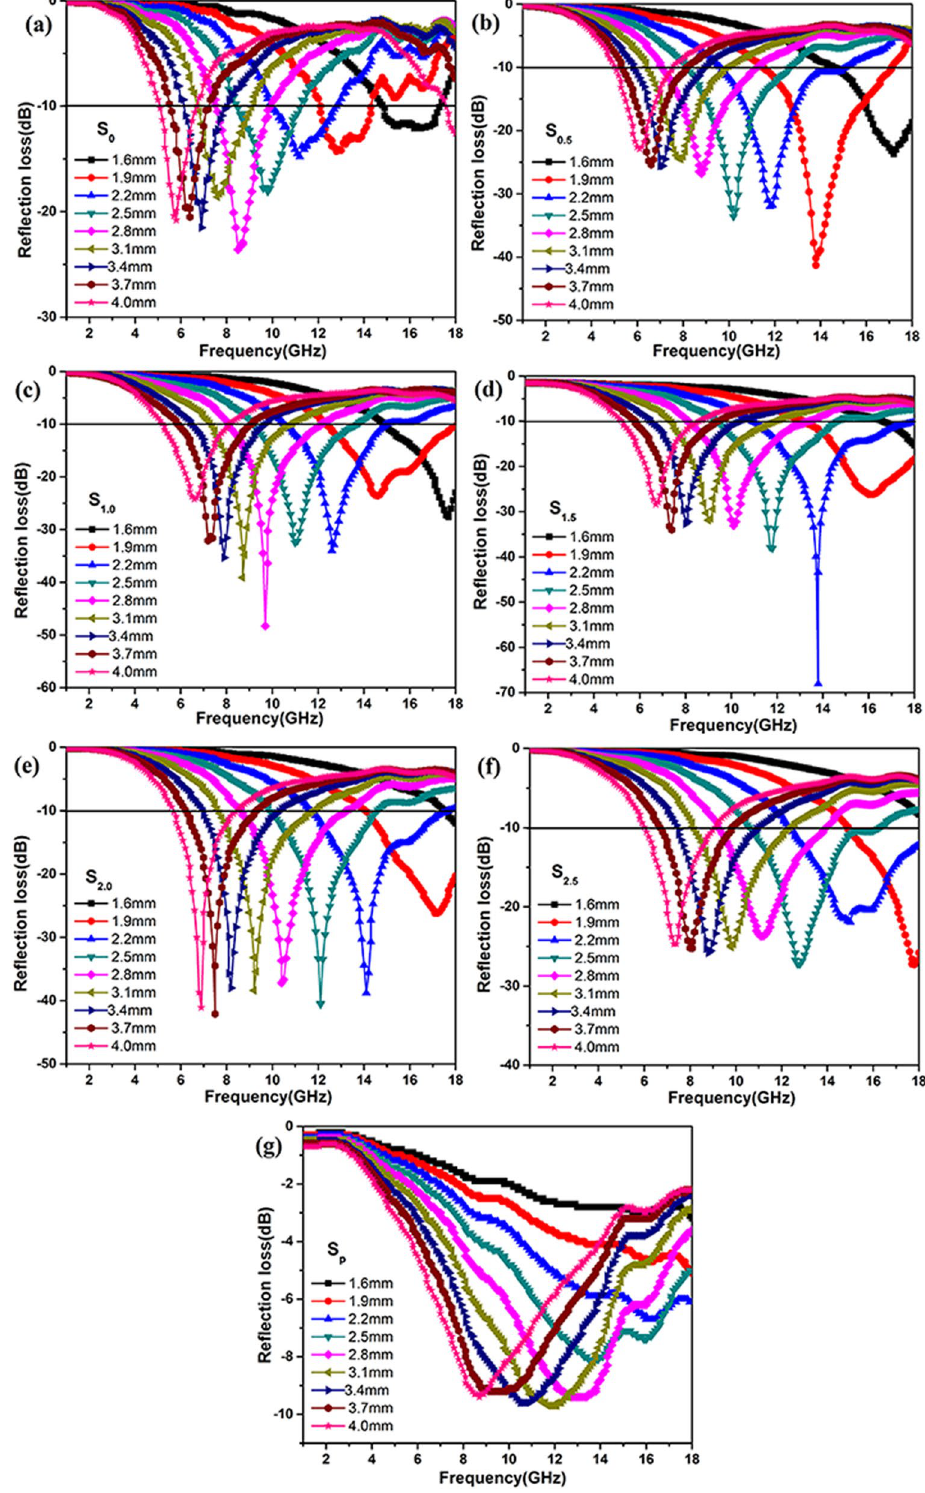
Figure 5. Calculated reflection loss of ( a ) S 0 , ( b ) S 0.5 , ( c ) S 1.0 , ( d ) S 1.5 , ( e ) S 2.0 , ( f ) S 2.5 , ( g ) S p with differents thickness in the frequency range of 1–18